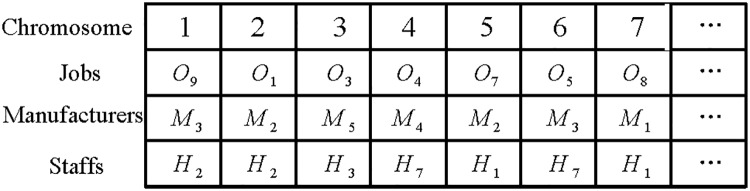
An example of chromosome structure.